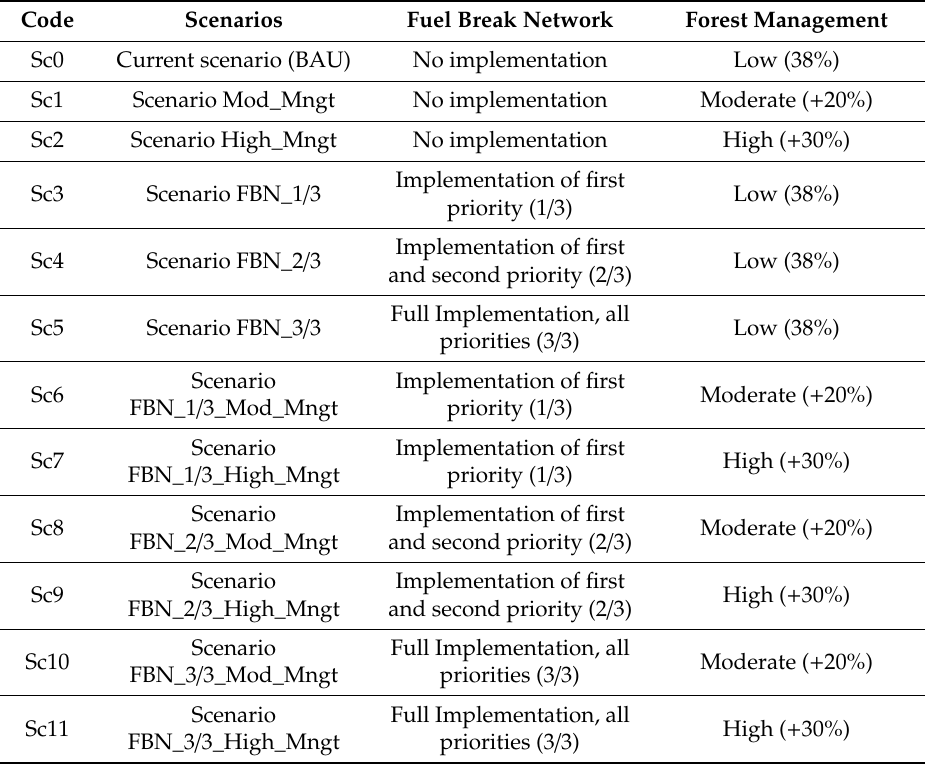
Table 3. Scenarios tested regarding current conditions (Sc0), level of forest management activities (Sc1-Sc2), fuel break network implementation (Sc3-Sc5), and possible combinations between fuel break and forest management